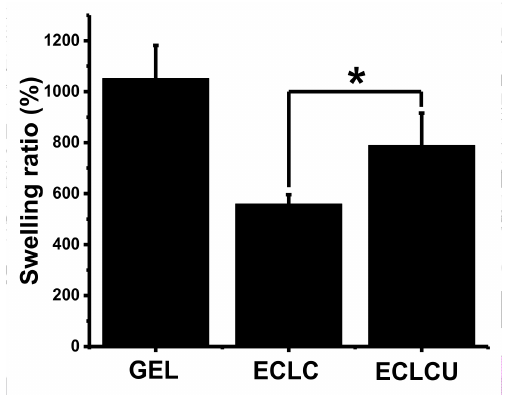
Figure 5. Swelling ratio of GEL, ECLC, and ECLCU (* indicates significant difference at p <